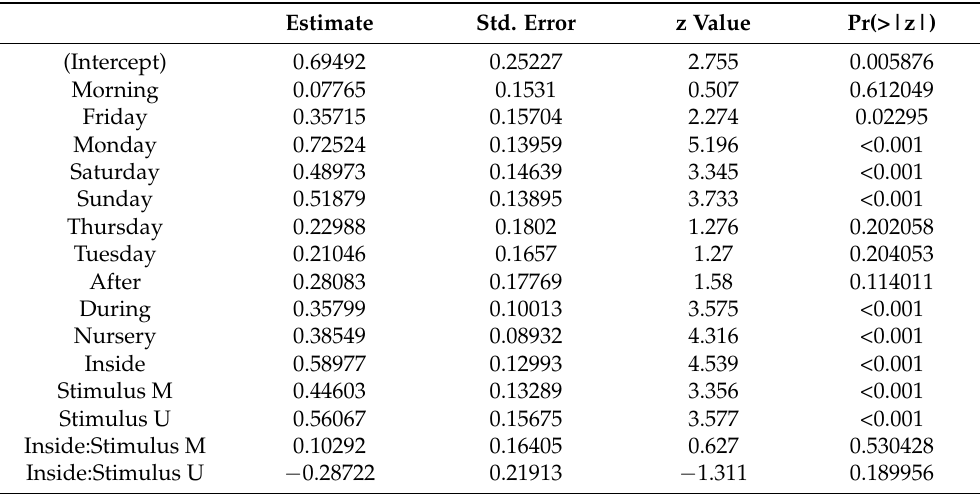
Table 4. Fixed effects table for the generalized linear model (GLM) fitted to the number of alarm reactions displayed by deer for type of stimulus, stimulus presented inside/outside the enclosure, time of the day, day of the week, exposure to tourists, group type and interaction between type of stimulus and inside/outside. Significance level set at p < 0.05. Estimate Std. Error z